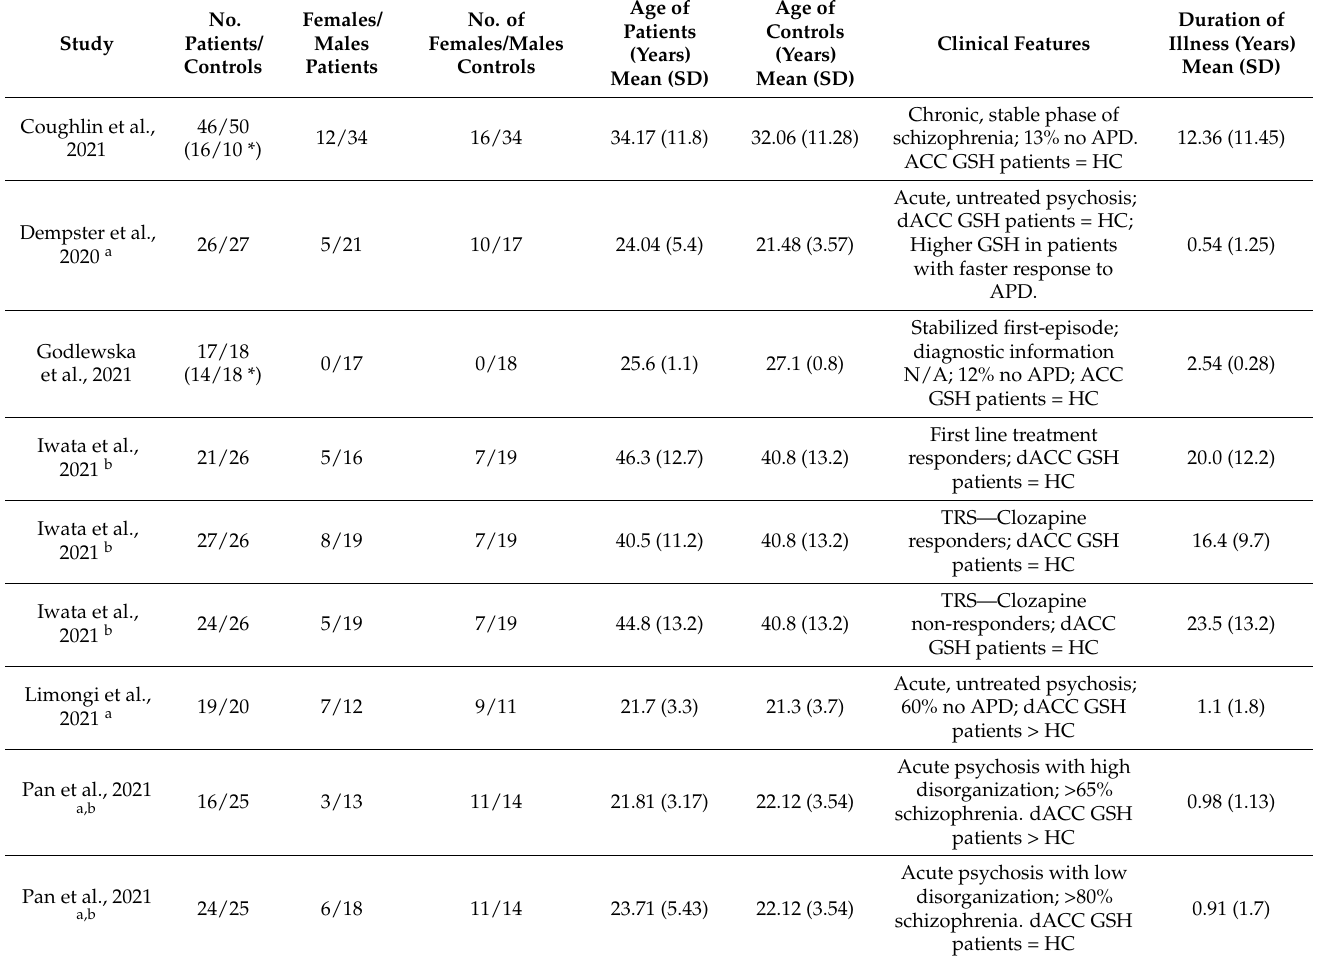
Table 1. Studies of intracortical GSH published since Das et al.,